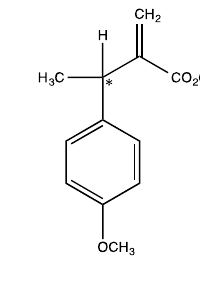
Figure 19. Reaction scheme and product distributions of the coupling reaction between 4- (trifluoromethyl)phenylboronic acid and methyl tiglate.